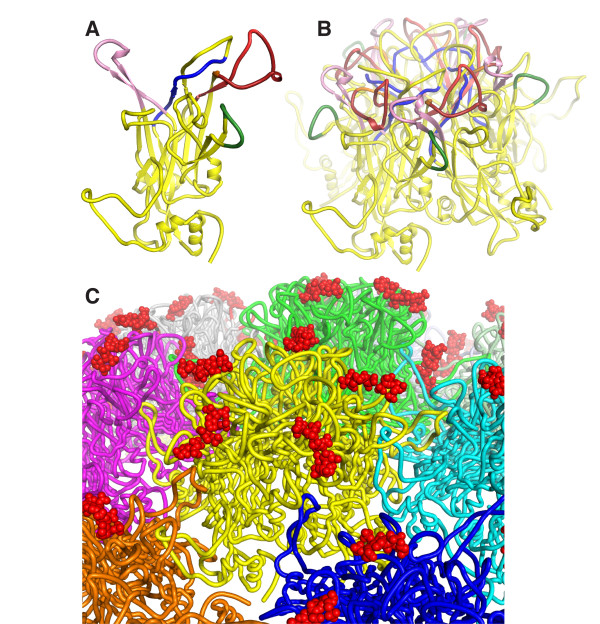
Atomic model of HPV16 L1 in the context of the T = 7 VLP. (A) A single subunit of L1 in the standard orientation. Residues 261-297 are in red and form part of the H16.V5, H16.E70, H263.A2 and H16.J4 epitopes. Residues 339-365 are in pink and form part of the H263.A2, H16.V5 and H16.E70 epitopes. Residues 174-185 are in dark green and form the H16.H5 epitope. Residues 111-130 are in blue and form the H16.I23 epitope. (B) A pentameric L1 capsomere with the same coloring scheme as in (A) and with the subunit in the foreground in approximately the same orientation as in (A). (C) A view of the HPV16 VLP surface with the capsomere in yellow in the same orientation as in (B) and heparin oligosaccharides as they bind to L1 capsomeres shown in red. The atomic model was generated as described in the Methods.